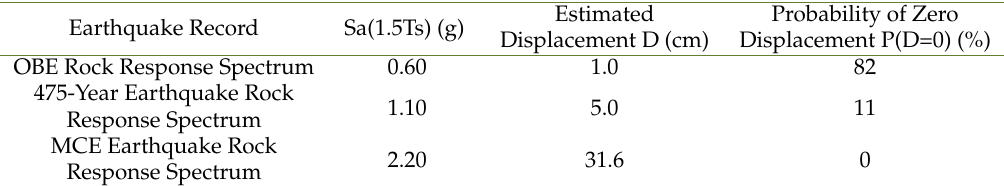
Table 6. Deviatoric Slope Displacements of Downstream